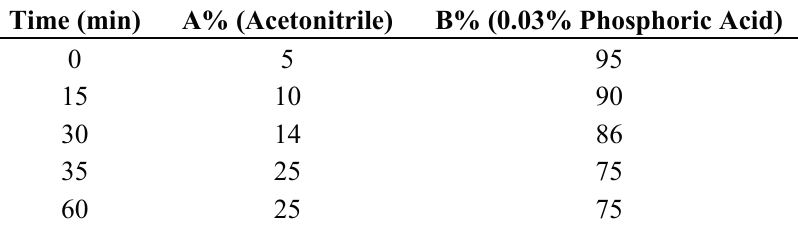
Table 1. The gradient elution program of the